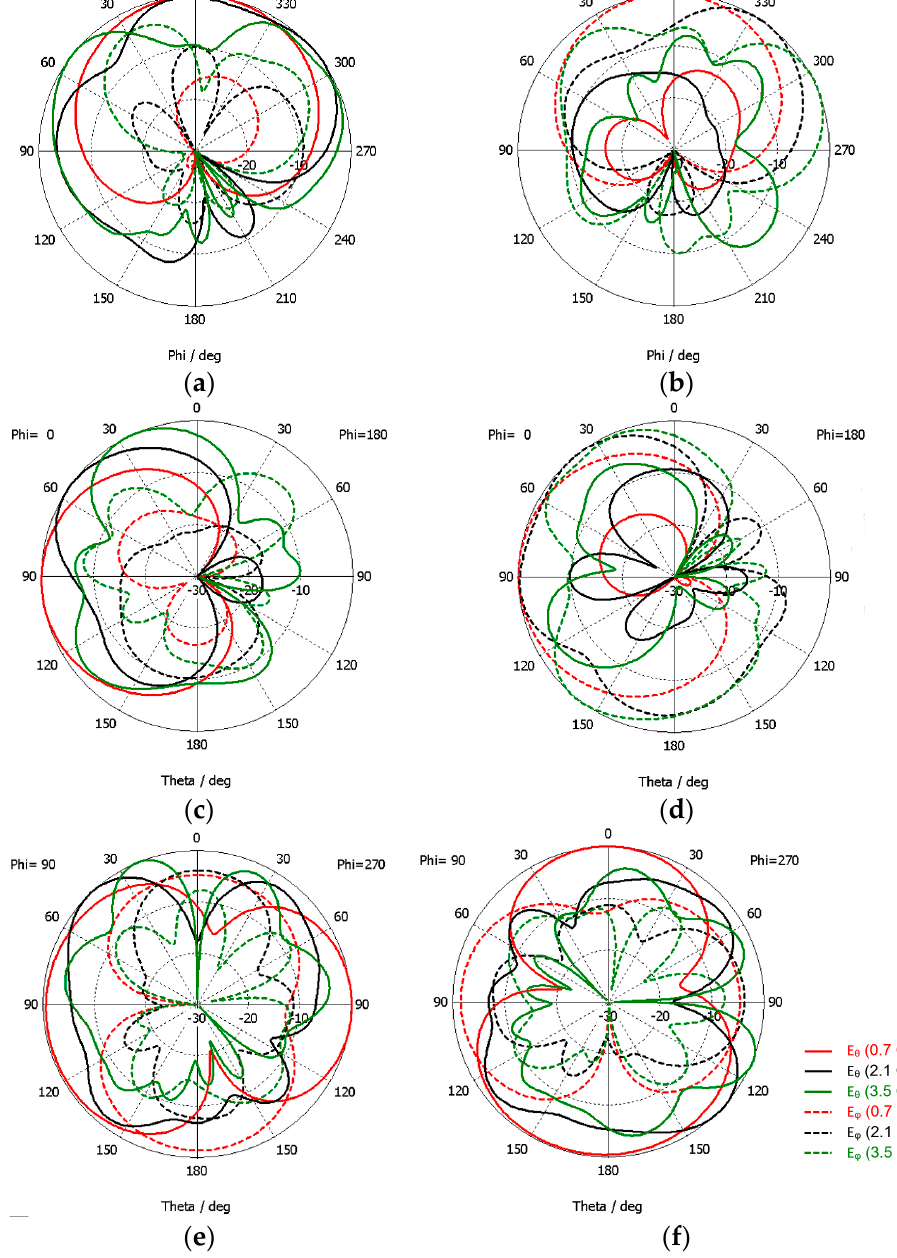
Figure 19. CST simulated far-field 2D radiation pattern results of the modified octagonal monopole with absorber and metal shield. ( a ) XY plane, Port 1; ( b ) XY plane, Port 2; ( c ) XZ plane, Port 1; ( d ) XZ plane, Port 2; ( e ) YZ plane, Port 1; ( f ) YZ plane, Port 2.